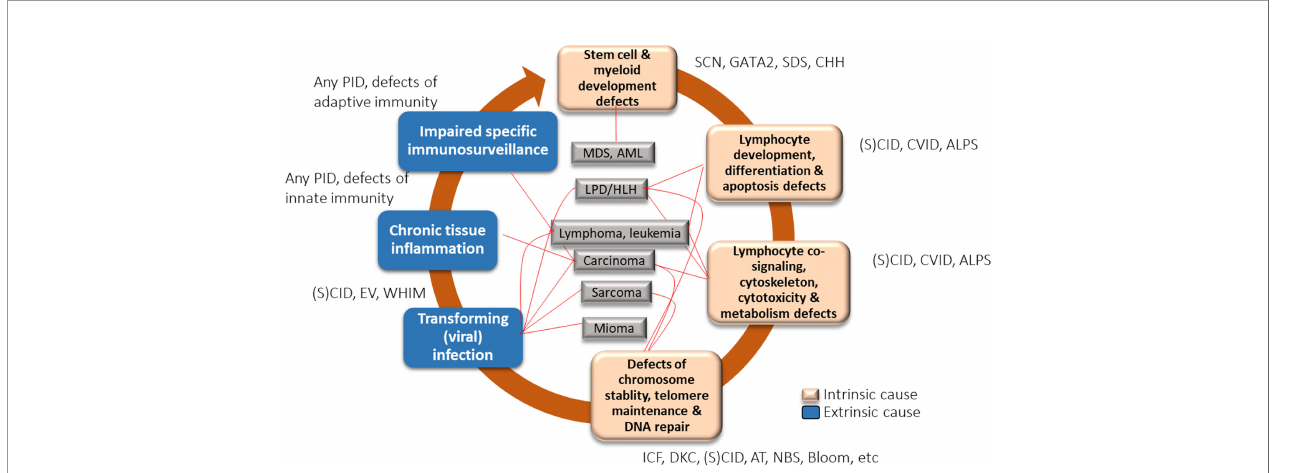
FIGURE 1 | Factors implicated in carcinogenesis in common variable immune de fi ciency (CVID) [created with data from Hauck et al., 2018 (34)]. ALPS, autoimmune lymphoproliferative syndrome; AML, acute myelogenous leukemia; CVID, common variable immune de fi ciency; DKC, dyskeratosis congenita; EV, epidermodysplasia verruciformis; IBD, in fl ammatory bowel disease; ICF, immunode fi ciency with centromeric instability and facial anomalies; LPD, lymphoproliferative disorder; MDS, myelodysplastic syndrome; PID, primary immunode fi ciency; (S)CID, (severe) combined immunode fi ciency; SDS, Shwachman-Diamond syndrome; SM, smooth muscle tumor; WHIM, warts, hypogammaglobulinemia, immunode fi ciency, and